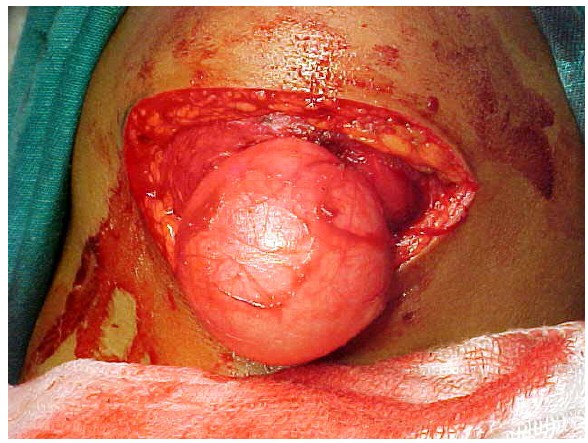
FIGURE 2. Transoperative view of the lesion after